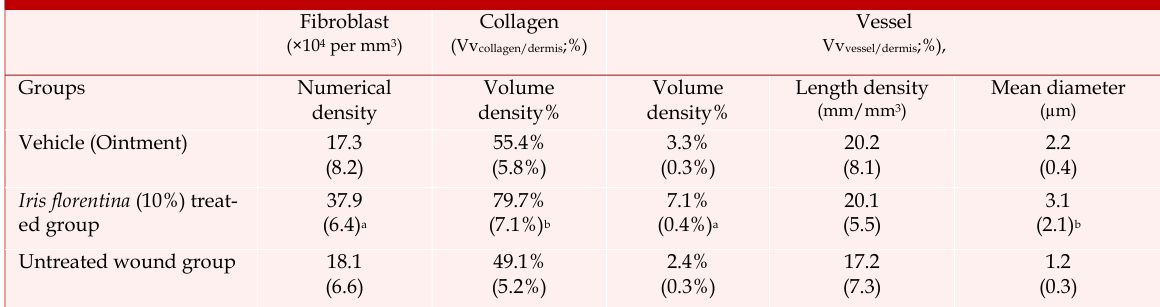
Effect of Iris florentina on fibroblasts, collagen and vessels in the dermis of the wounded